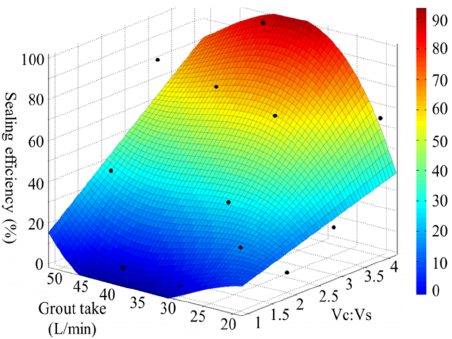
Figure 15. Combined influence of the grout take and the mixture ratio of grout on sealing